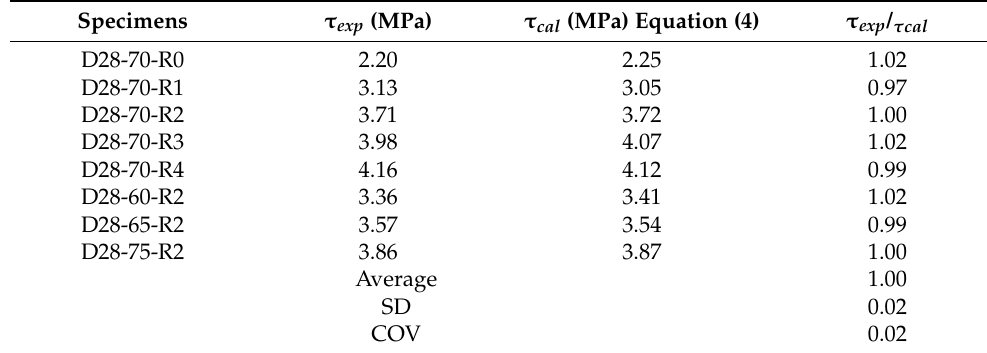
Table 6. Comparison of the shear bond stress between the experimental and Equation